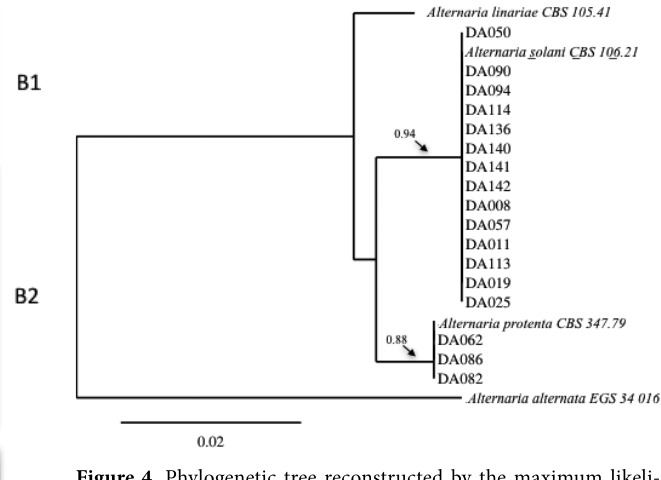
Figure 4. Phylogenetic tree reconstructed by the maximum likeli- hood method from the alignment of RPB2 sequences of 17 isolates belonging to cluster B2 in the calmodulin phylogeny. Bootstrap support values greater than 80 % are indicated by arrows. The RPB2 sequences of the following strains were included as references: